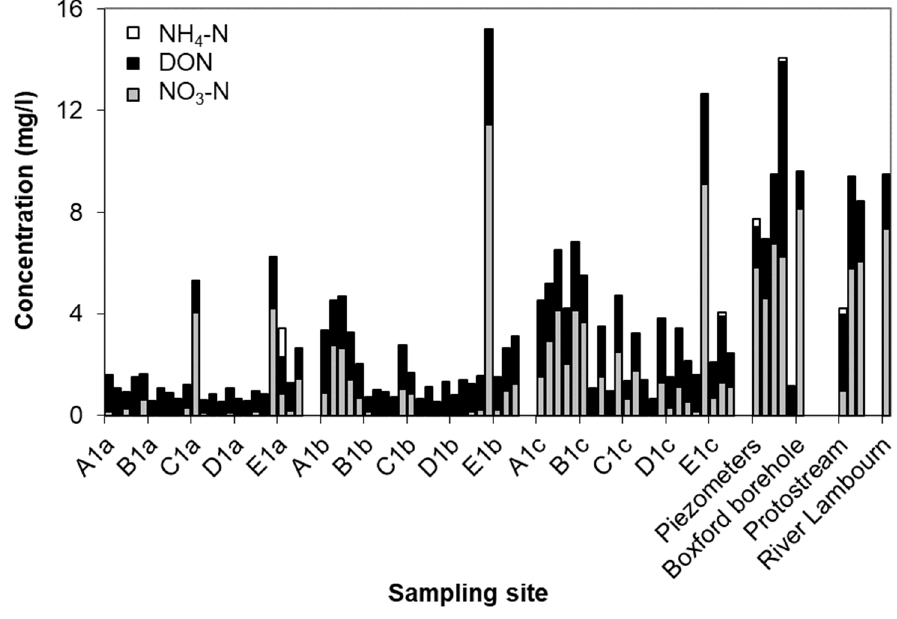
Figure 9. Baseflow N chemistry in the Boxford wetland, 16 September 2003 to 16 January 2005.